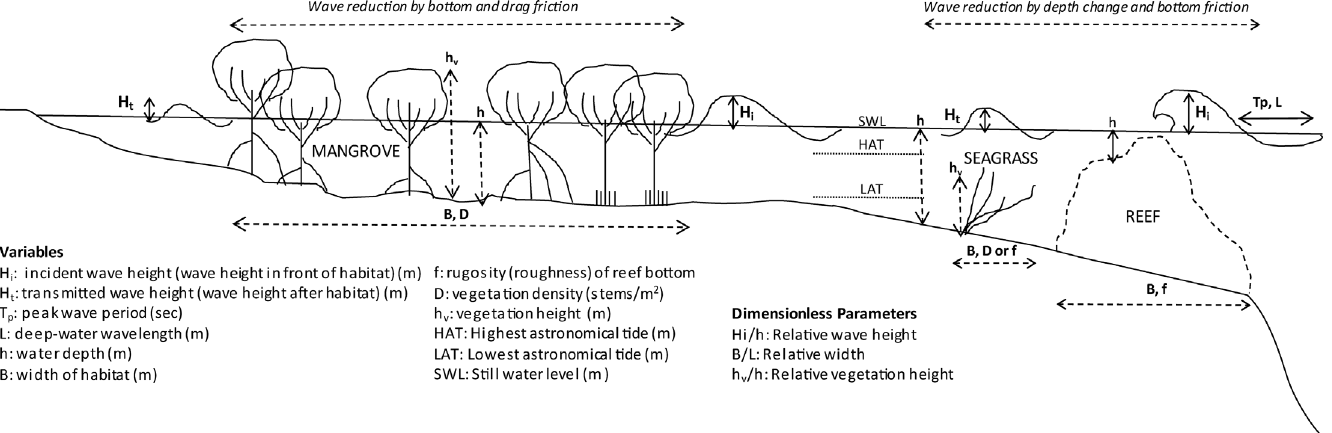
Fig 1. Schematic of wave height reduction across coastal habitats. Schematic showing general mechanics of wave height reduction through habitats, using the examples of coral reefs, seagrass beds and